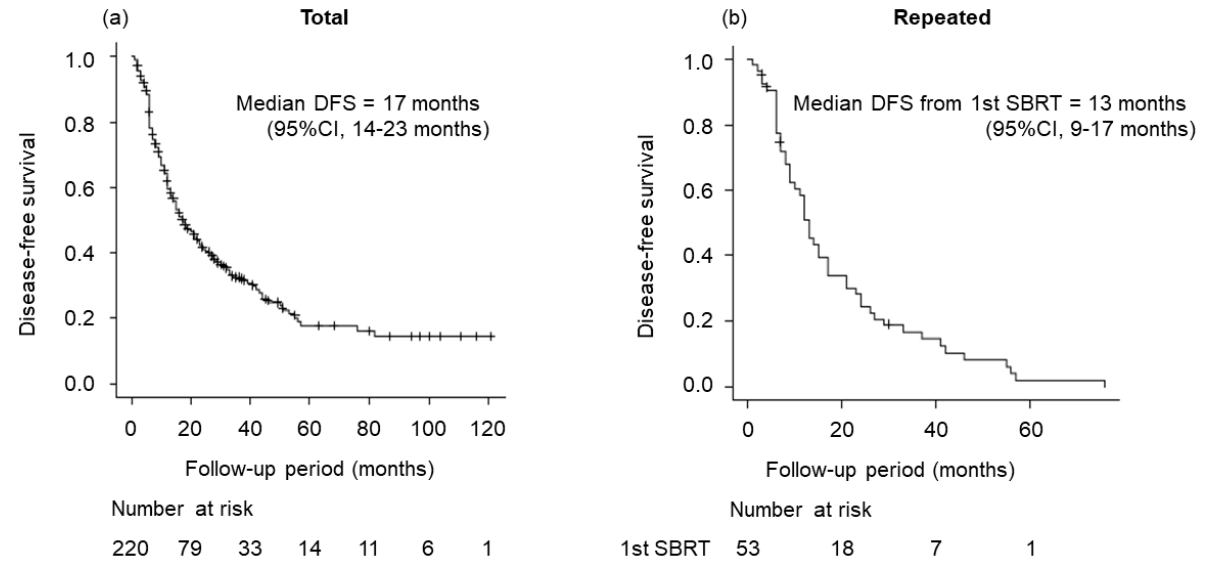
Figure 3. Disease-free survival (DFS) for total cases treated with SBRT and repeated cases treated with SBRT. ( a ) DFS for total cases (median DFS, 17 months; 95% CI, 14–23 months). ( b ) DFS for repeated cases (median DFS from first SBRT, 13 months; 95% CI, 9–17 months).